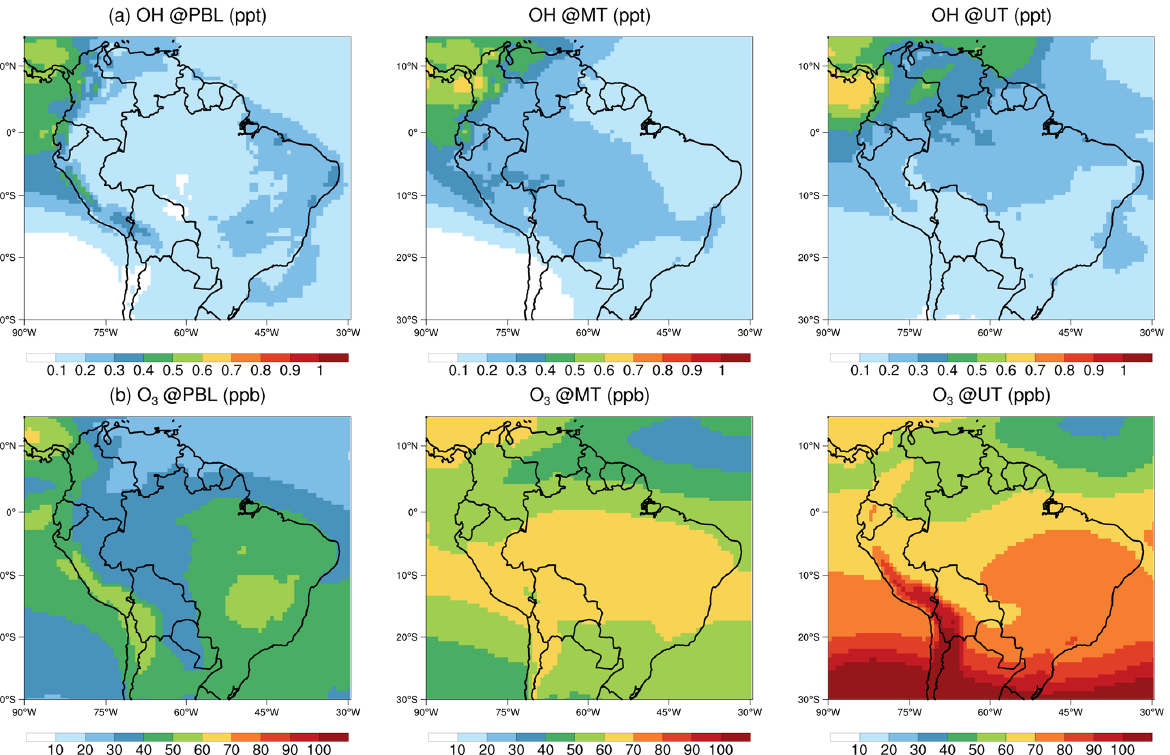
Figure A8. Horizontal distribution of (a) OH and (b) O 3 averaged over 1 September–1 October 2014 from the CTRL case. The concentrations are at STP.